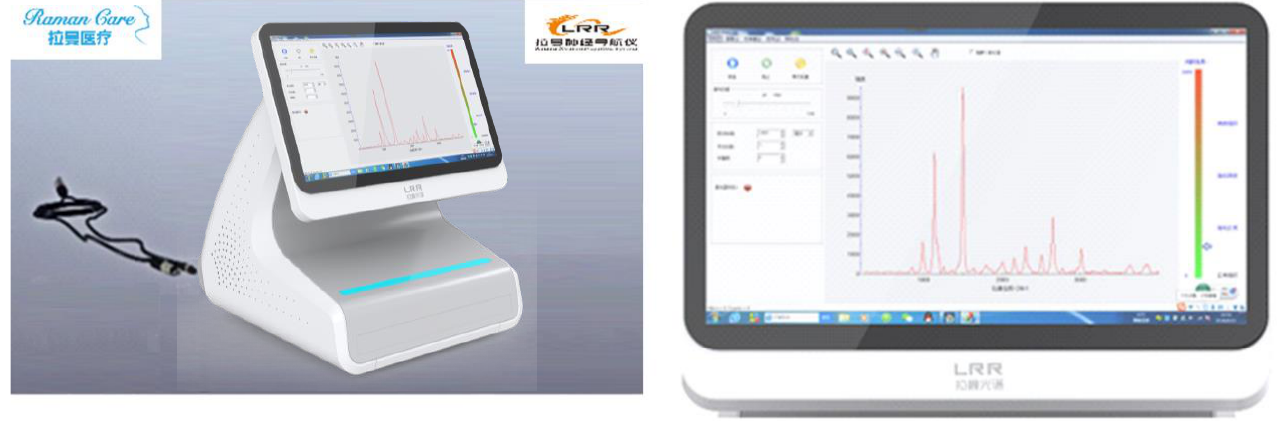
Figure 1. Photographs of the portable VRR-LRR TM analyzer with a label-free optical-fiber probe along with example experimental data. The analyzer is 32 cm × 33 cm × 38 cm in size and weighs 7.5 kg, with a standard cable of probe of 2 m. The screen displays recorded signals and test results, along with flickering color and ringtones in real time (right side of screen). When the surgical resection is challenging, the tissue may be located at the border of the tumor with the real-time display of classification; the VRR-LRR TM handheld probe provides the results and helps the surgeon to decide whether to remove the tissue [45].